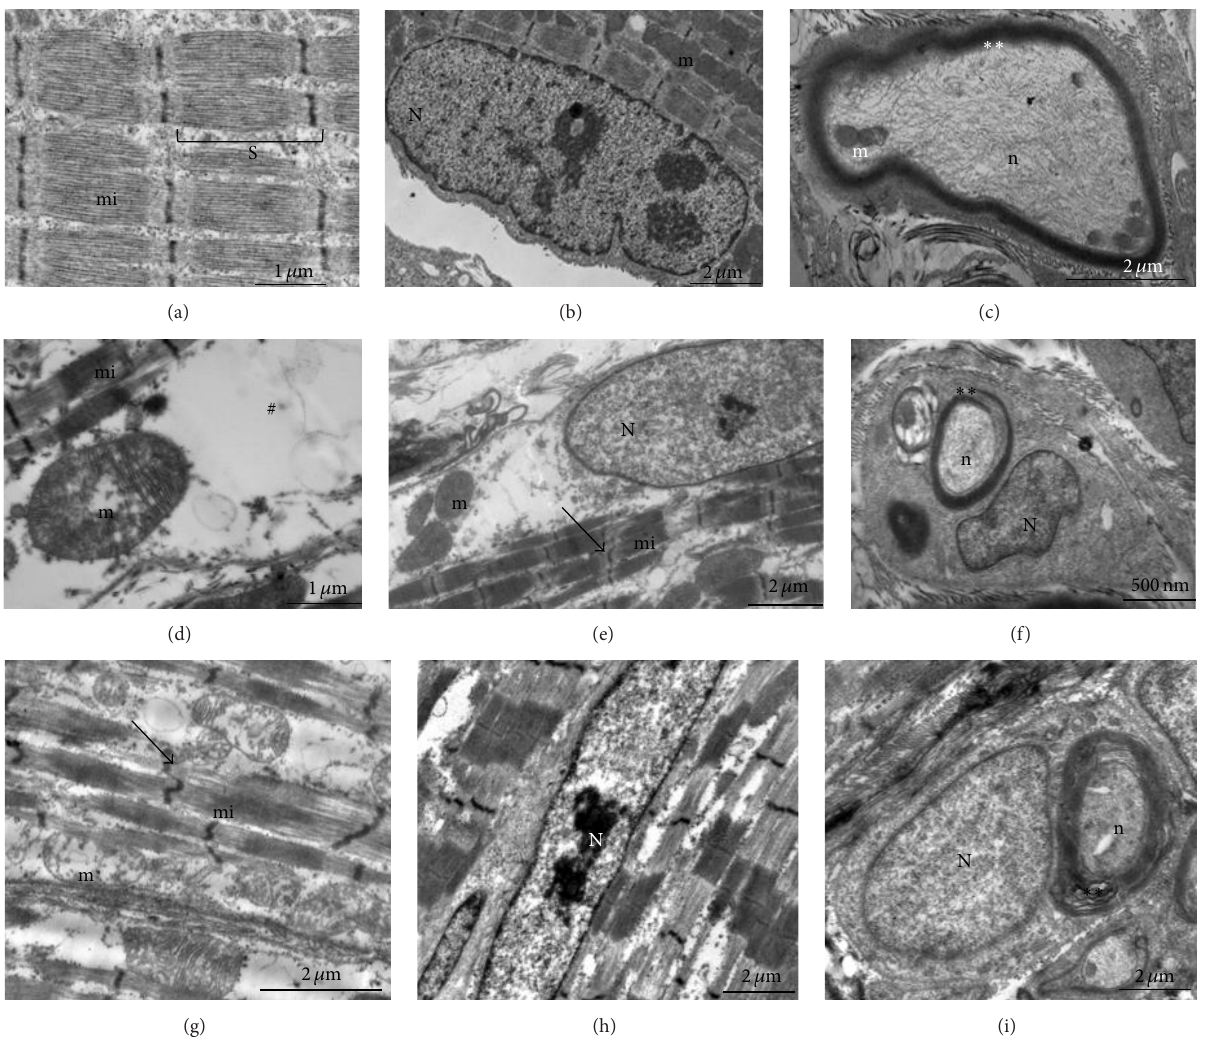
Figure 4: Electron micrographs of chick biventer cervicis preparations incubated in Krebs solution (control, (a)–(c)), BmjeTX-I ((d)–(f)), and BmjeTX-II ((g)–(i)) toxins. No alterations were observed in control ((a)–(c)). Treated preparations ((d)–(i)) displayed hypercontracted myofilaments (mi) and loss of typical sarcomeres (S) organization, edema (#), mitochondria (m), swelling, and cristae deprivation. Myonuclei (N) of some fibres showed apoptotic-like phenotype and intramuscular nerve fibres were affected ( ∗∗ ); n: neurofilaments; arrows: blurred Z line ( 𝑛 = 4 per